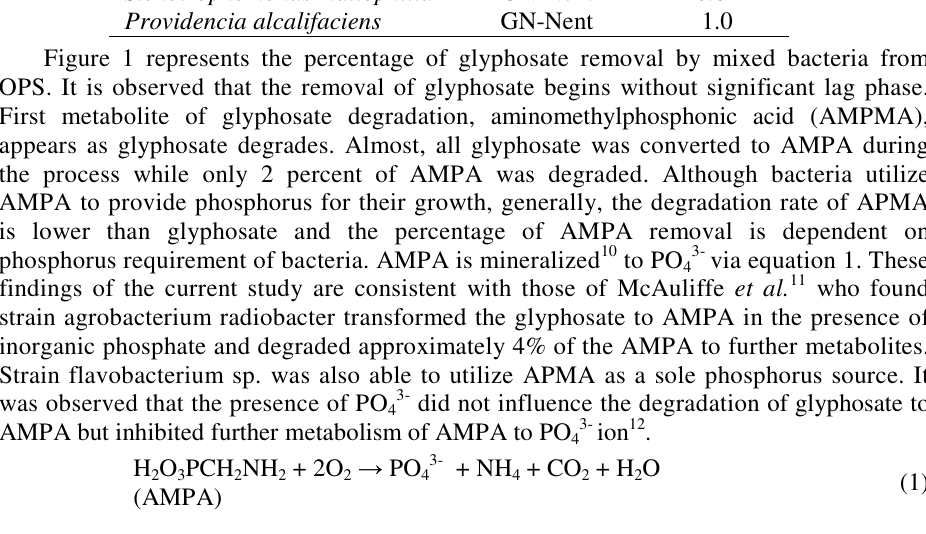
Table 1. Identification of degrading bacteria for glyphosate Species Organism